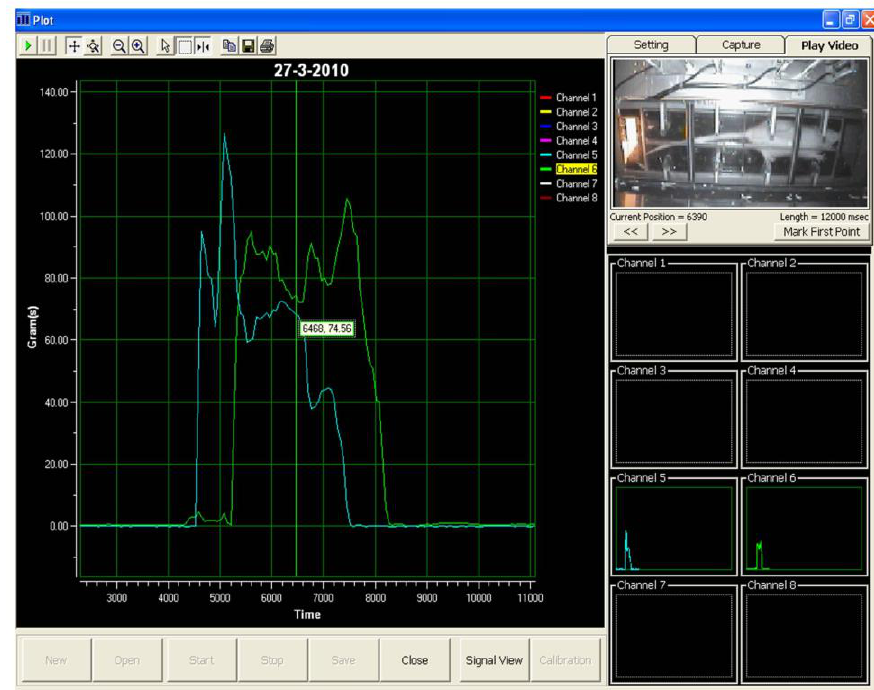
Figure 7. Intermittent movements of the